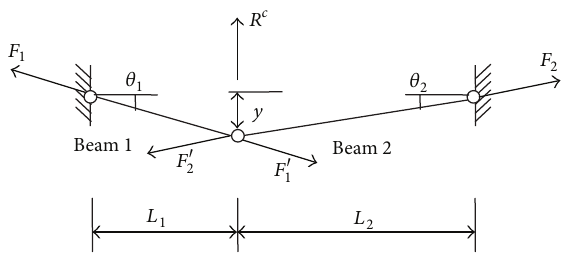
Figure 11: Force equilibrium diagram in CA stage [18].